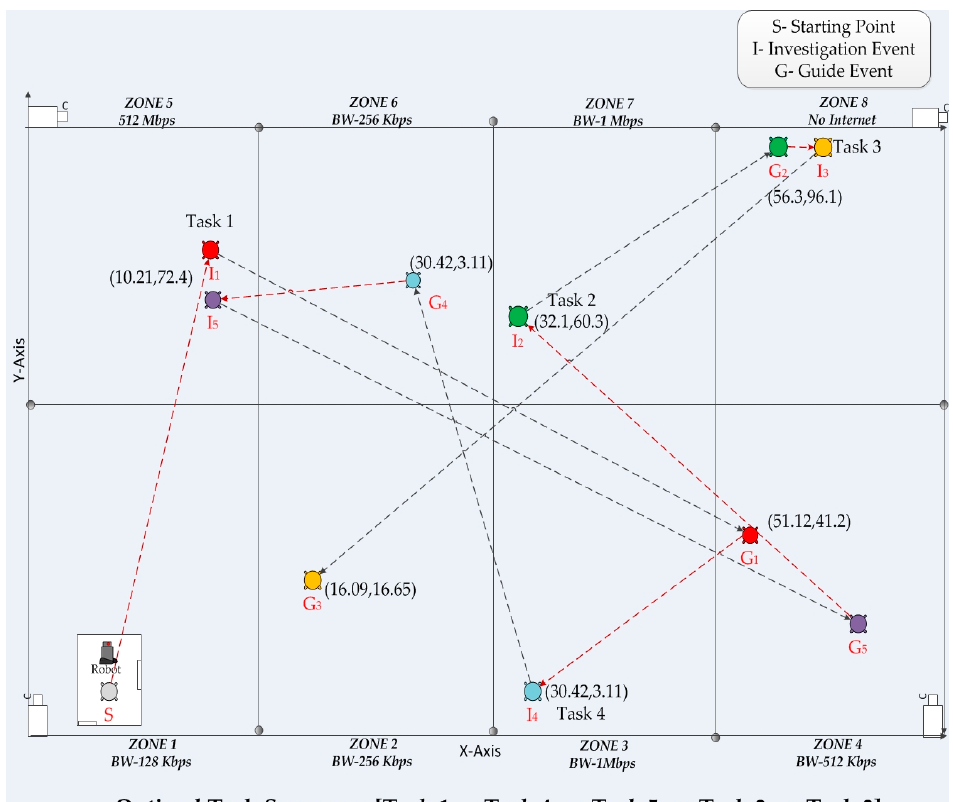
Figure 10. Optimal task sequence for a multi-task flow offloading problem.